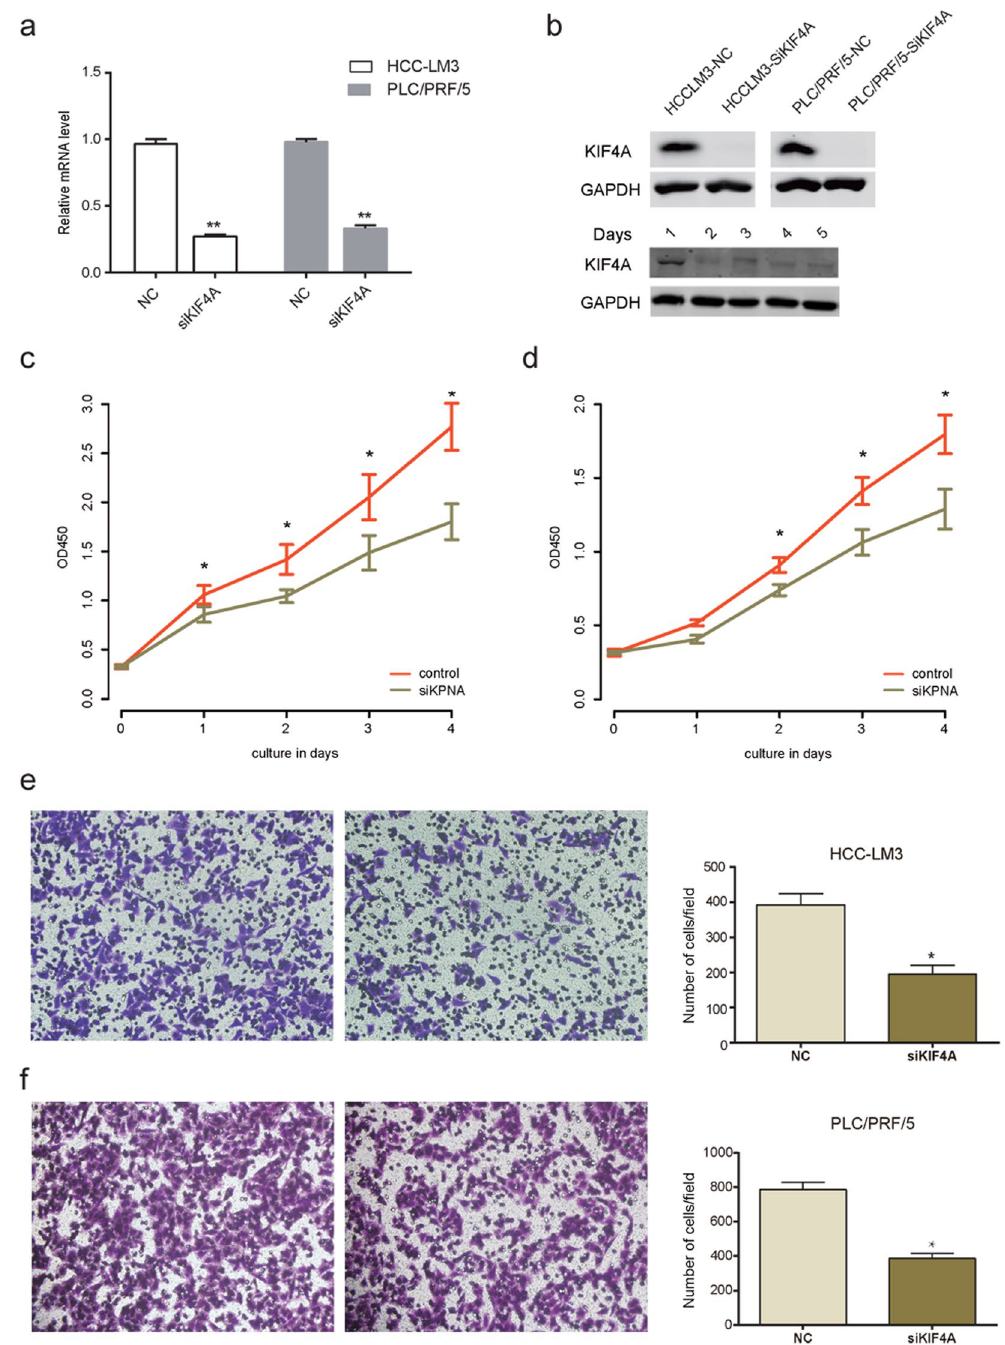
Figure 3. The proliferation and migration promoting effect of KIF4A in HCC cell lines. KIF4A expression was suppressed by RNAi in mRNA ( a ) and protein ( b ) level (upper panel, KIF4A protein expression in HCC-LM3 and PLC/PRF/5 cell lines; lower panel, each time point protein expression of KIF4A in HCC-LM3 cell line); KIF4A knockdown decreased cell proliferation rate of HCC-LM3 ( c ) and PLC/PRF/5 ( d ); KIF4A knockdown impaired migration rate in HCC-LM3 ( e ) and PLC/PRF/5 ( f